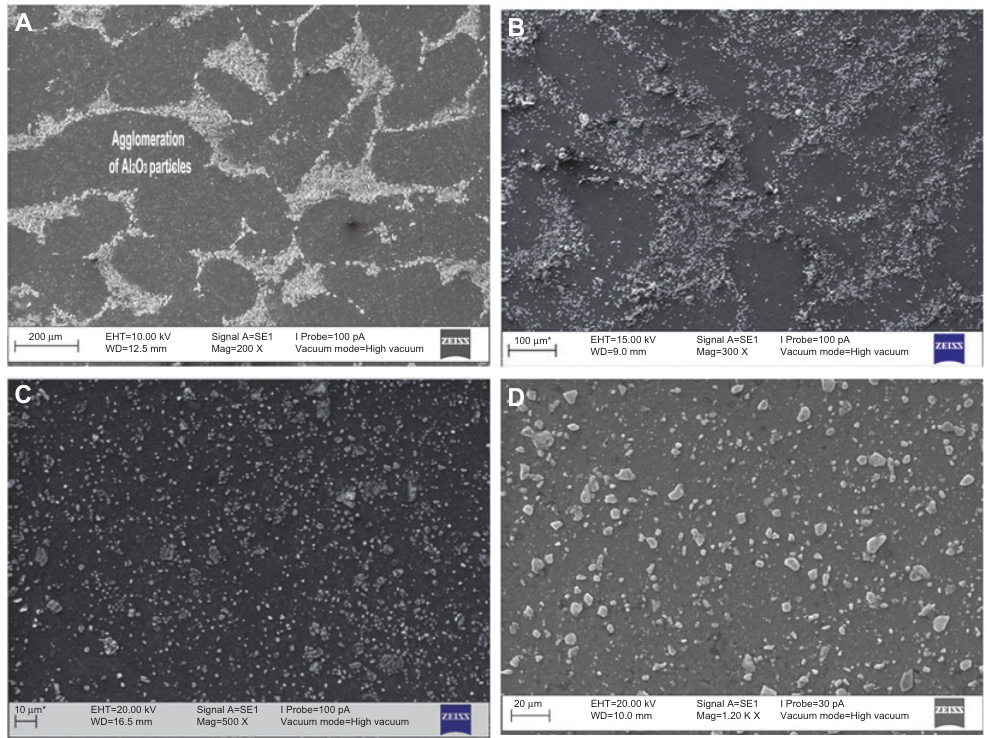
Figure 11 Distribution of Al (D) 7 h.